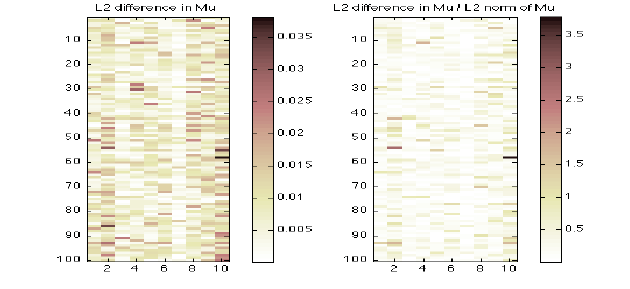
Figure 3: Heatmap of L 2 differences (absolute and relative) between entries of true B and estimated B .